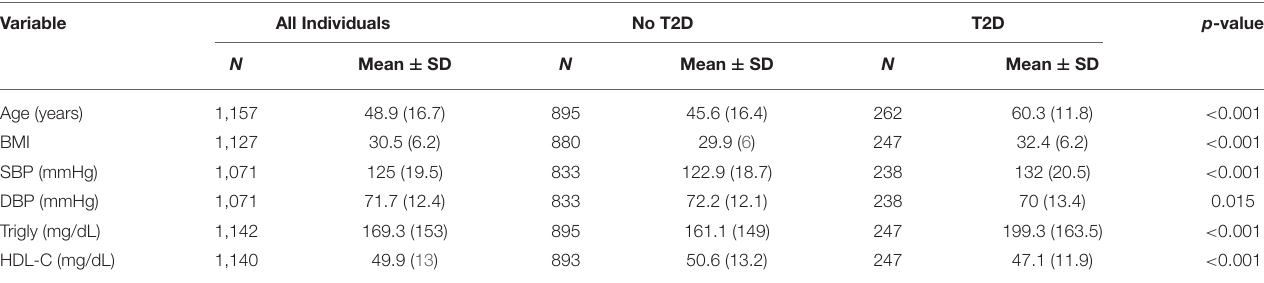
TABLE 6 | General description and stratification by T2D status of selected variables from the HHANES ¶ .